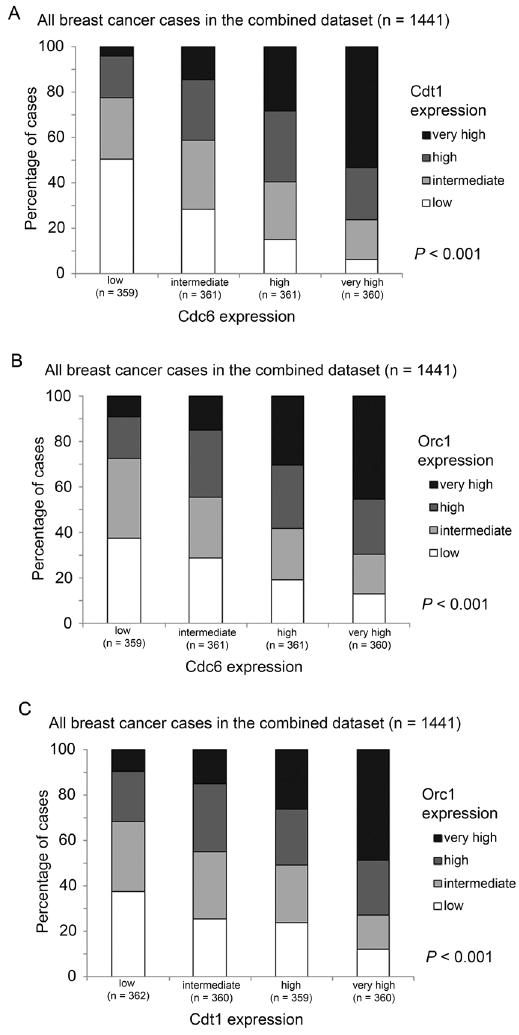
Figure 2. The associations between the expression levels of Cdc6, Cdt1 and Orc1 in breast cancer specimens. Histograms showing percentage of specimens that expressed different levels of ( A ) Cdc6 vs. Cdt1, ( B ) Cdc6 vs. Orc1 and ( C ) Cdt1 and Orc1, in breast cancer